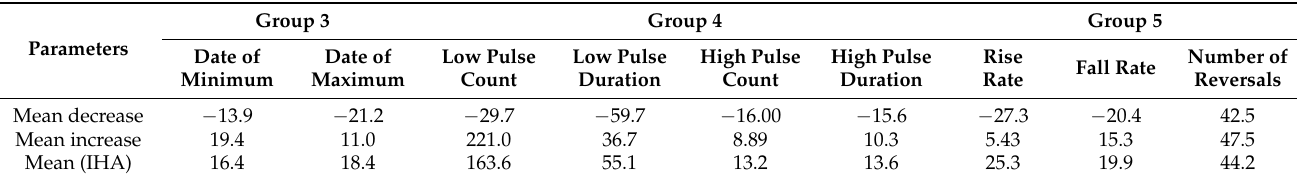
Table 6. Change (in days) in the means of the timing of annual extreme flows (group 3 of IHA parameters) and change (in %) in the mean frequency and duration of high and low pulses (group 4 of IHA parameters), as well as the rate and frequency of hydrologic changes (group 5 of IHA